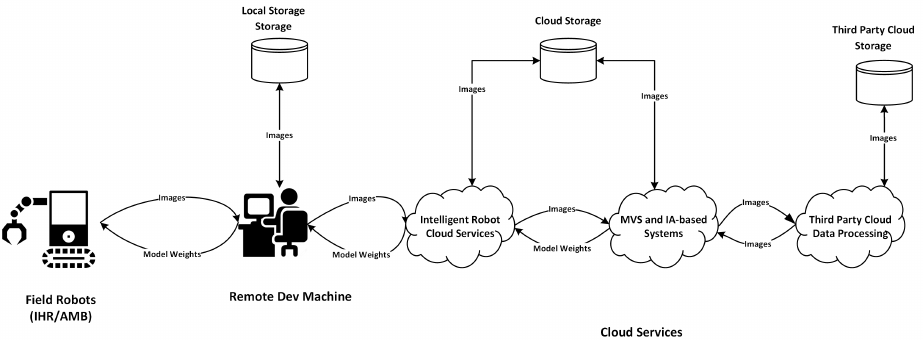
Figure 2. Machine vision system